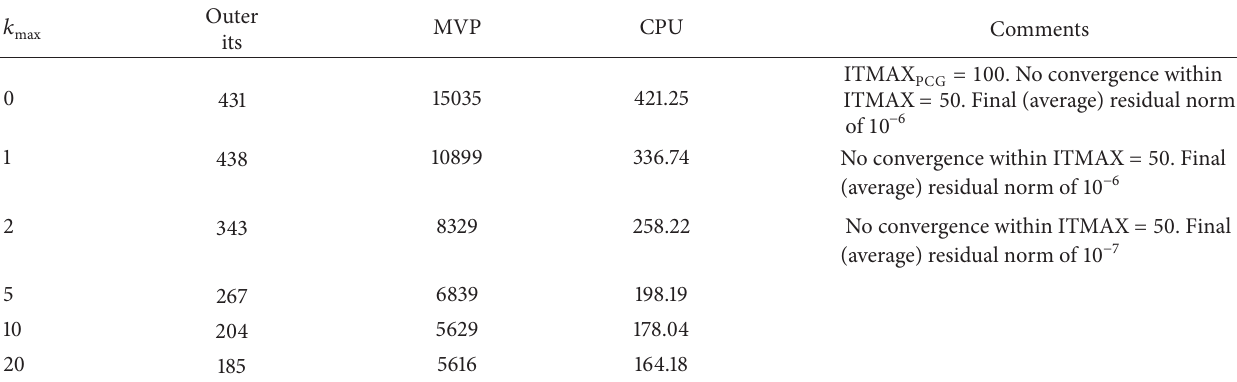
Table 4: Influence of parameter 𝑘 max in the number of iterations of the Newton phase. Problem EMILIA-923 with 𝑝 = 64 processors.